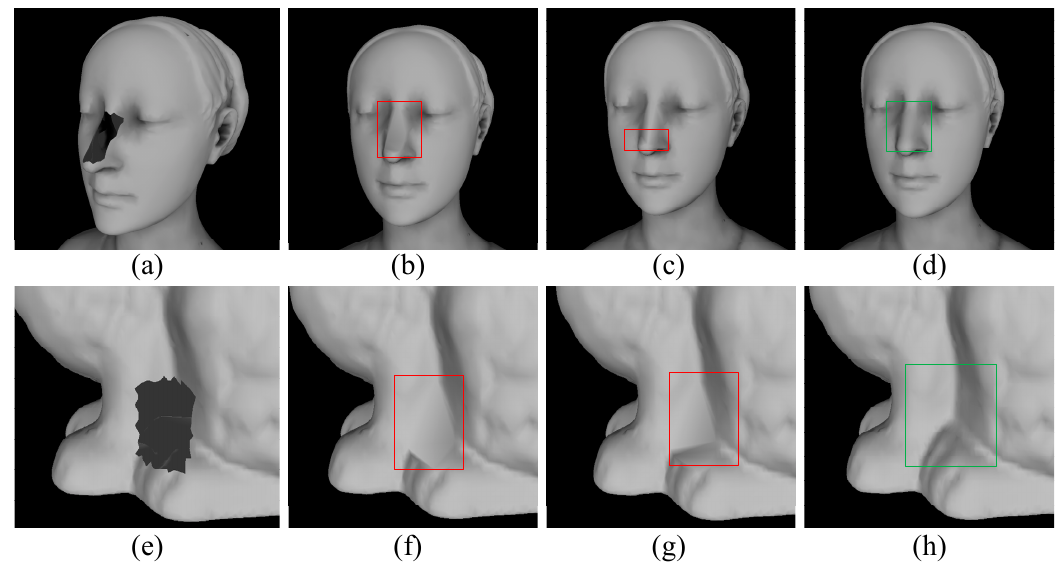
Figure 11. The holes filling results of the Laurana model and Bunny model: (a) Laurana with a hole on her nose and (e) a hole on the feet of Bunny; (b) and (f) are hole filling results of VCG; (c) and (g) are hole filling results of MeshFix; (d) and (h) are hole filling results of LIMOFilling.